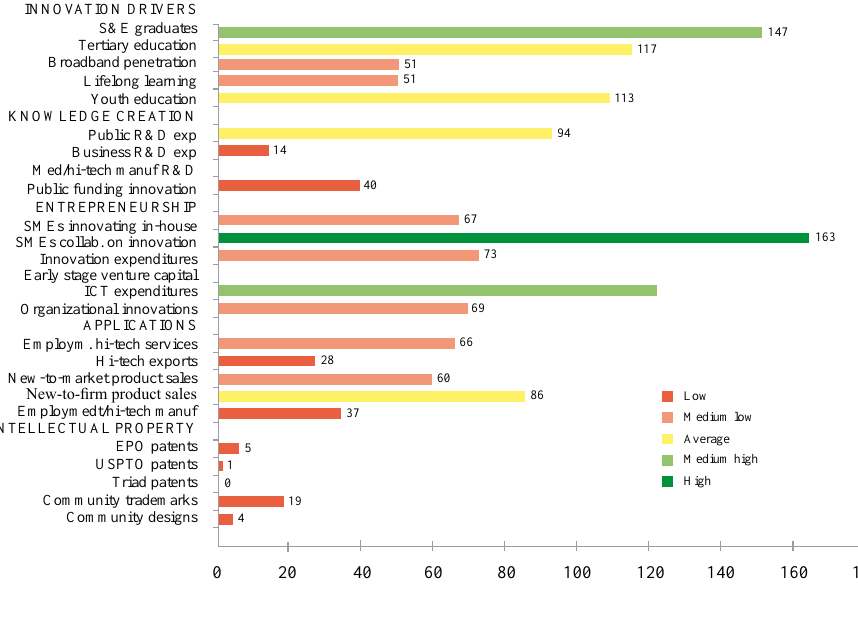
fig. 5. Innovation performance chart. Source: European Innovation Scoreboard ... 2001